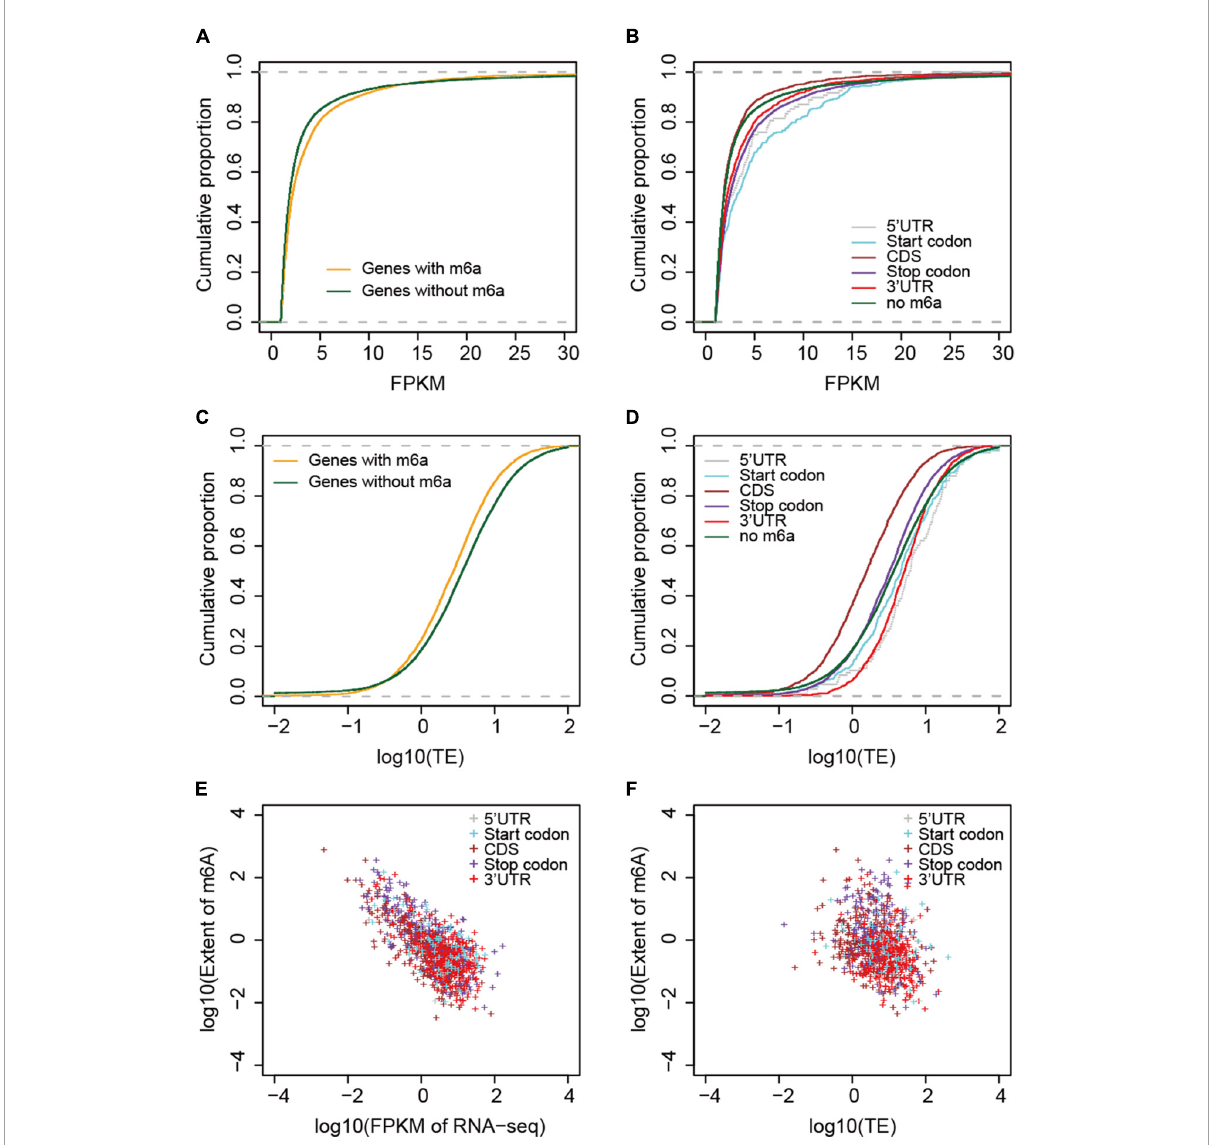
FIGURE5 Correlation between m6A methylation and gene expression and translation levels. (A) Comparison of mRNA abundances (measured by FPKM) between non-methylated and m6A-containing mRNAs. (B) Comparison between different groups of m6A-containing mRNAs. (C) Comparison of mRNA translation efficiencies between m6A-containing and non-methylated mRNAs. (D) Comparison of translation efficiencies between different groups of m6A-containing mRNAs. (E) Correlation between the extent of m6A methylation and mRNA abundances, and (F) mRNA translation efficiencies. The different groups of m6A-containing mRNAs were color